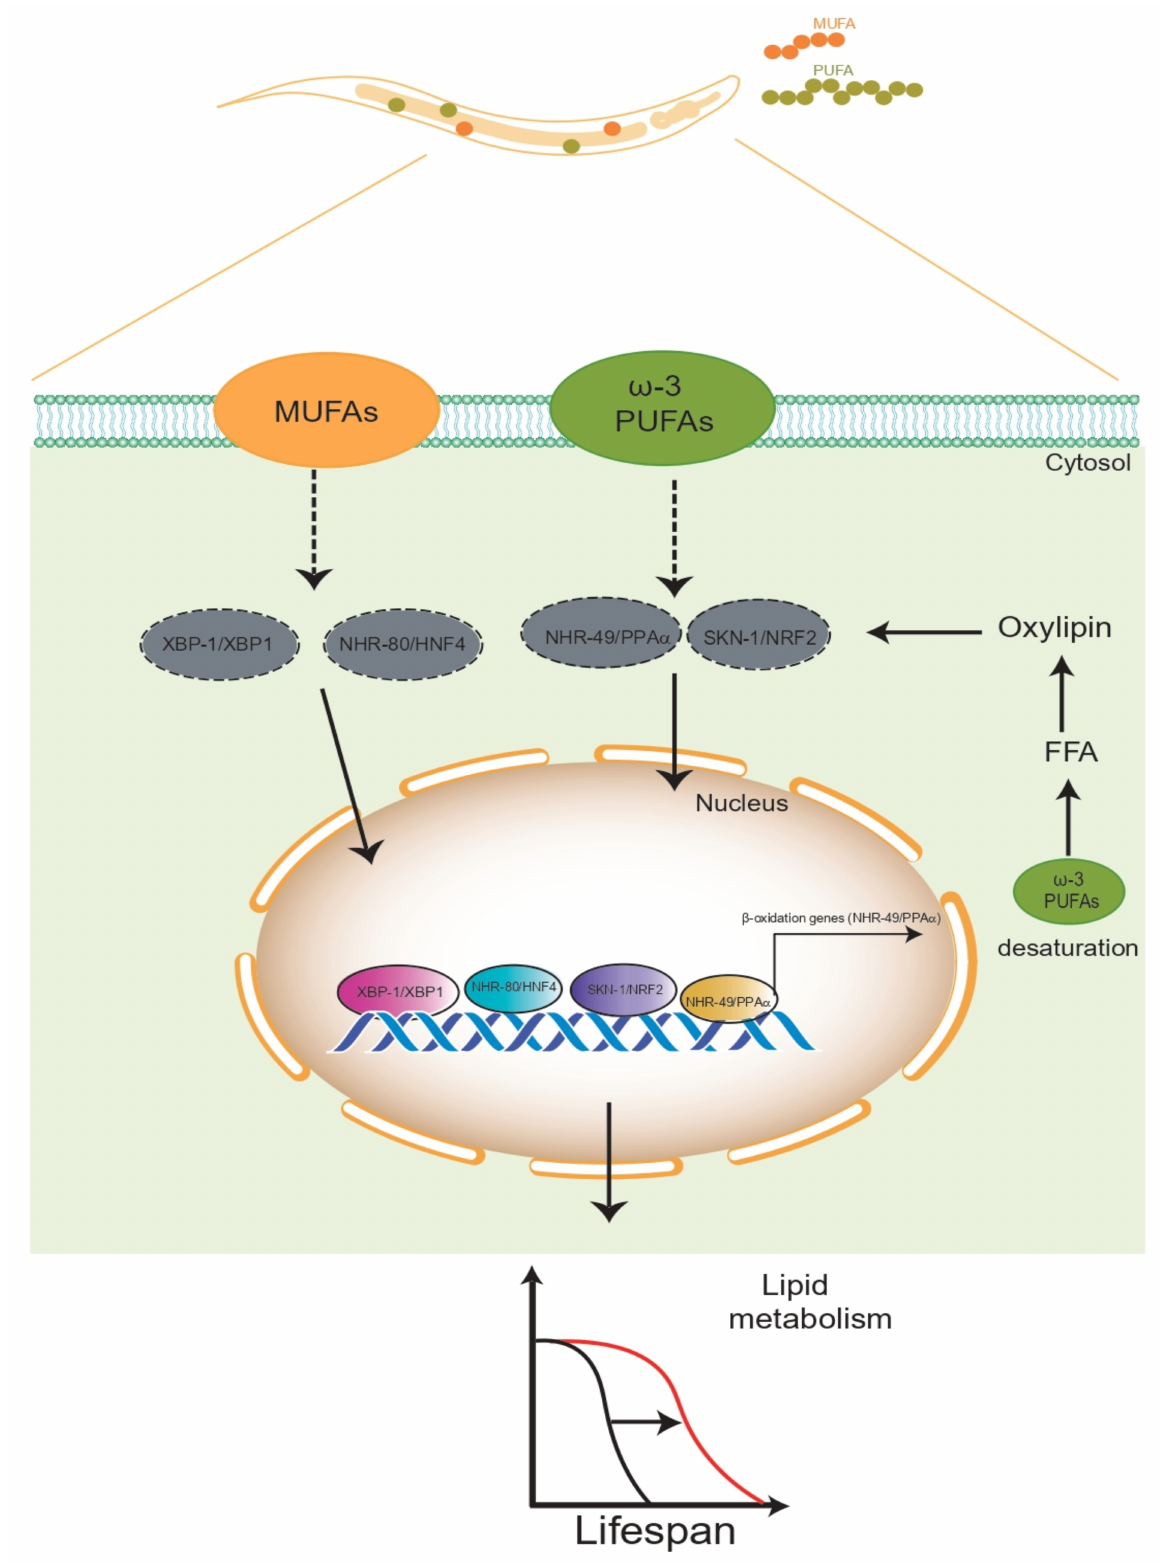
Figure 4. Effects of different dietary lipids on the lifespan of C. elegans . Exogenous MUFAs and PUFAs contribute to lifespan extension via activation of several transcriptional factors that promote gene transcription of enzymes for fatty acid desaturation, which might play an important role in the positive regulation of the